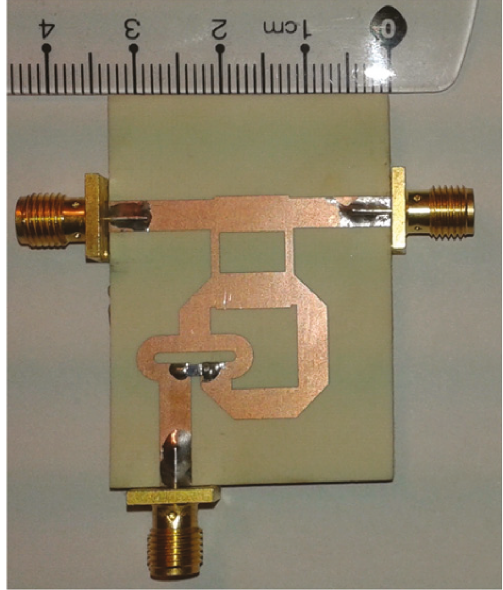
Figure 9: Fabricated sample of the three-way divider with C = 7 dB, K = 1 , and R = 100 Ω .